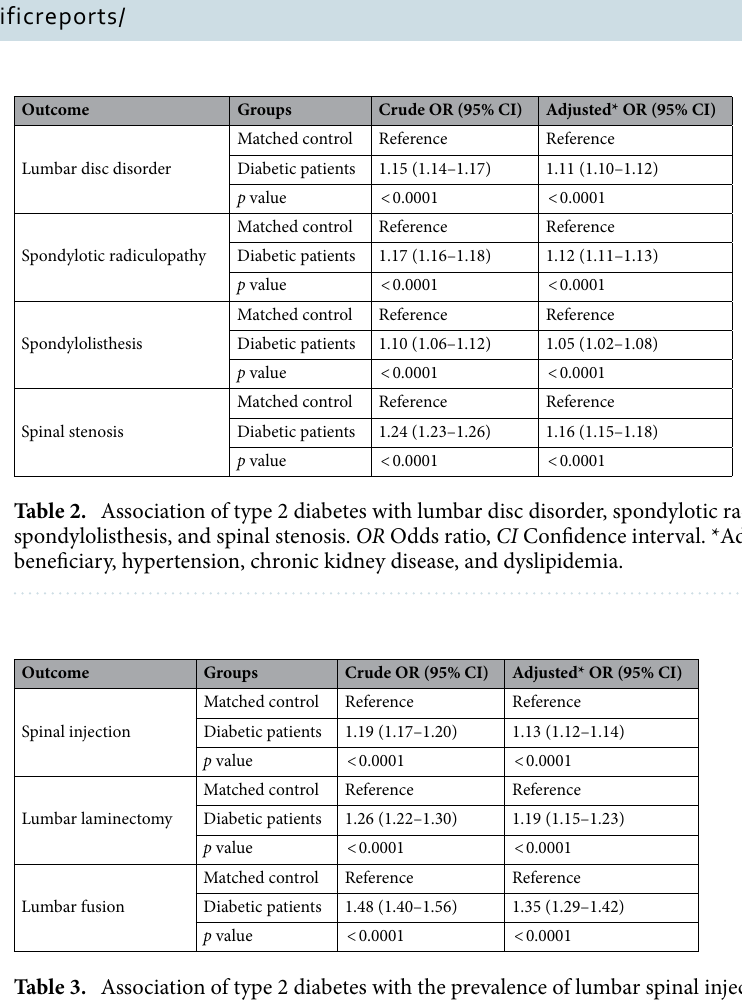
Table 3. Association of type 2 diabetes with the prevalence of lumbar spinal injection, laminectomy, and lumbar fusion. OR Odds ratio, CI Confidence interval. *Adjusted by age, sex, type of beneficiary, hypertension, chronic kidney disease, and